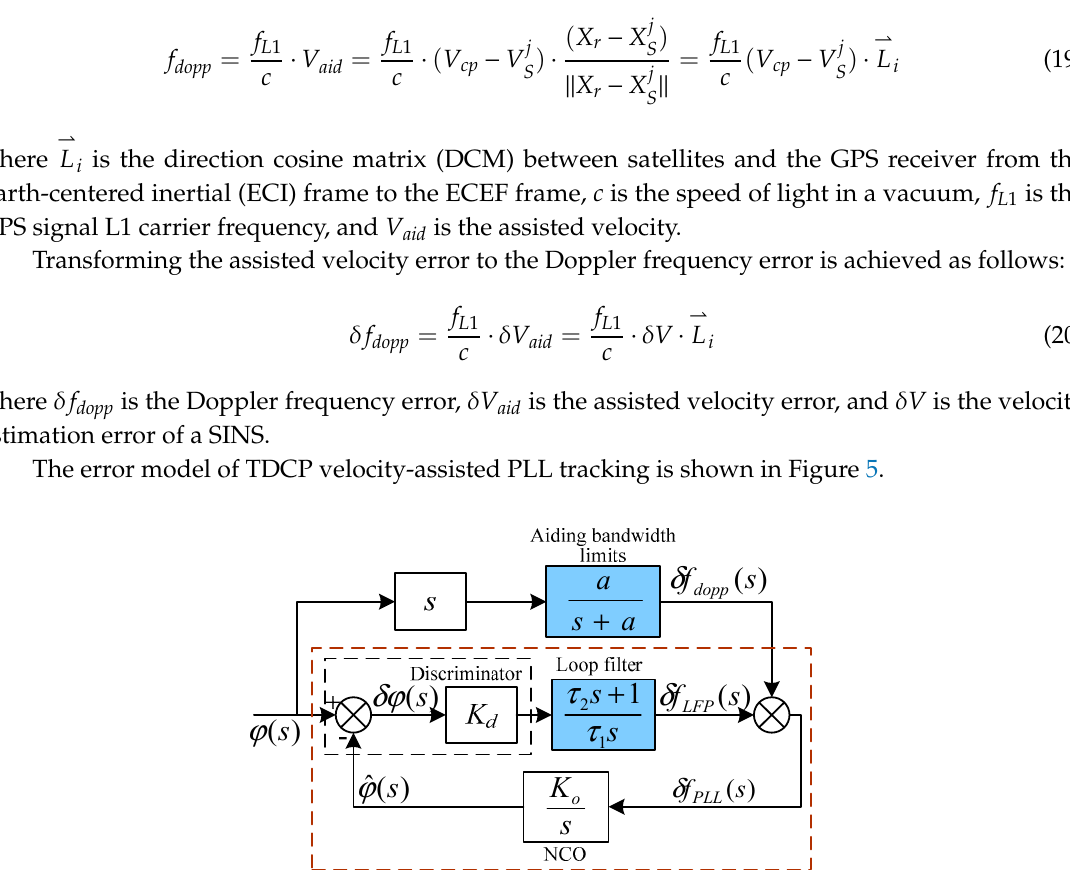
Figure 5. Model of TDCP velocity-assisted PLL tracking. Where ϕ is the phase of the input